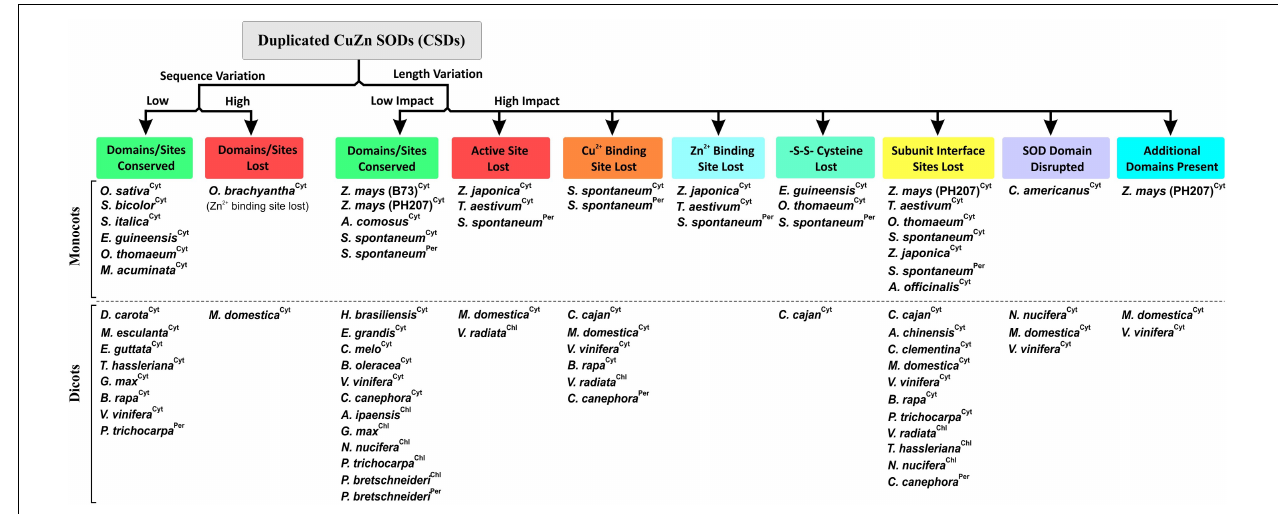
FIGURE 12 | Simplified grouping of divergence-mediated effects on the important features of duplicated copies of CuZn SOD isoforms (Cyt, cytosolic; Per, peroxisomal; Chl, chloroplastic) among monocots and dicots.